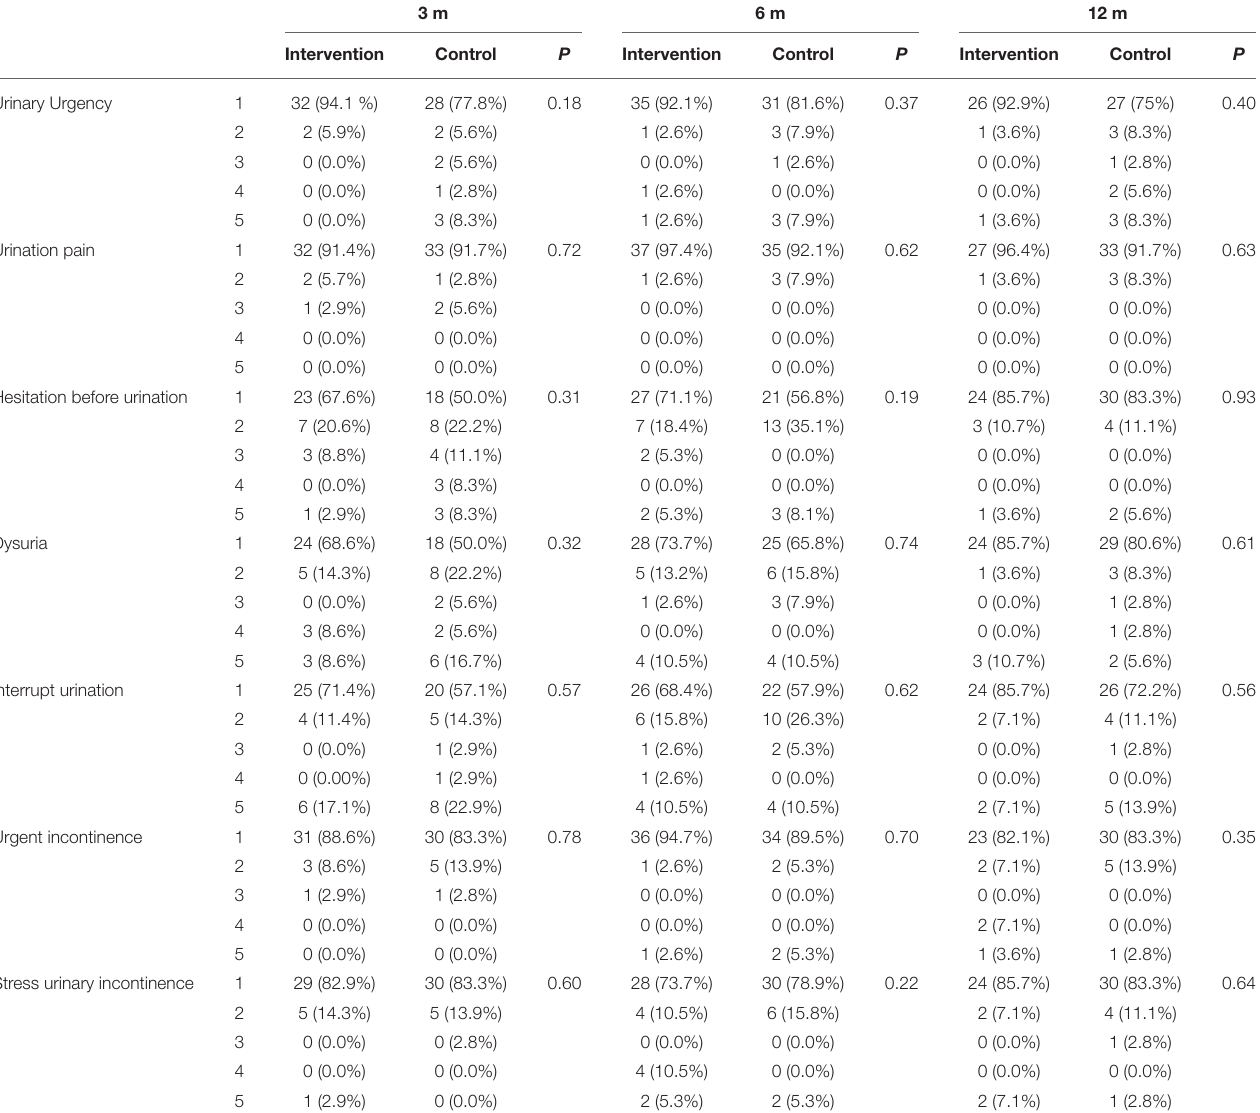
TABLE 4 | LUTS based on ICIQ between the 2 groups at 3 rd mo., 6 th mo., and 12 th mo. after